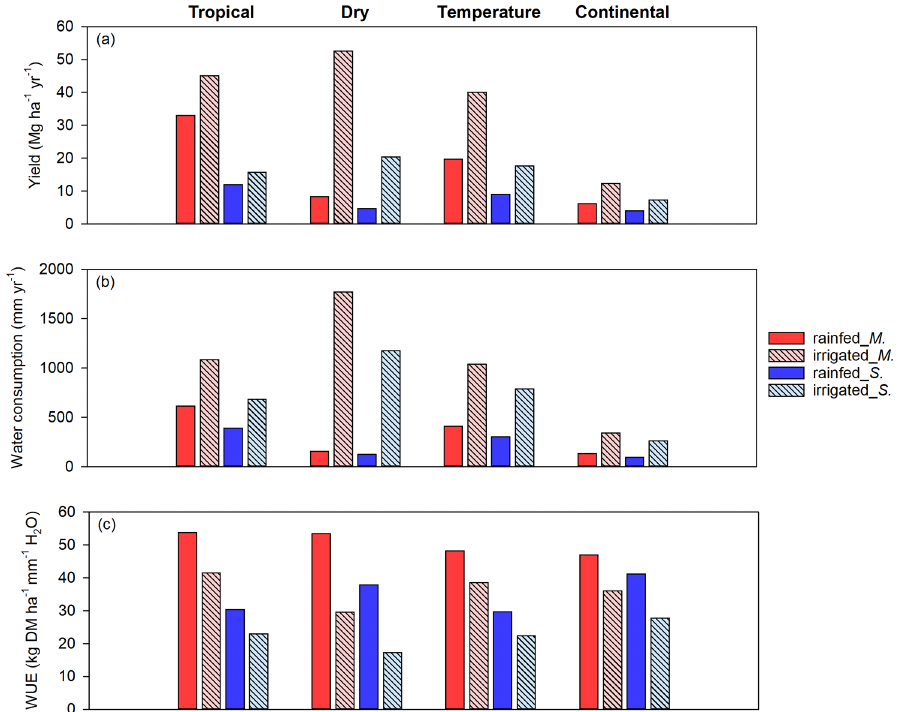
Figure 10. Variation in the average yield (a) , crop water consumption (b) , and water use efficiency (WUE) (c) of Miscanthus and switchgrass under rainfed and irrigated conditions in four different Köppen climate zones (tropical, dry, temperate, and continental climates) based on meteorology data collected from 1979 to 2016. The abbreviations M. and S. in the legend denote Miscanthus and switchgrass,